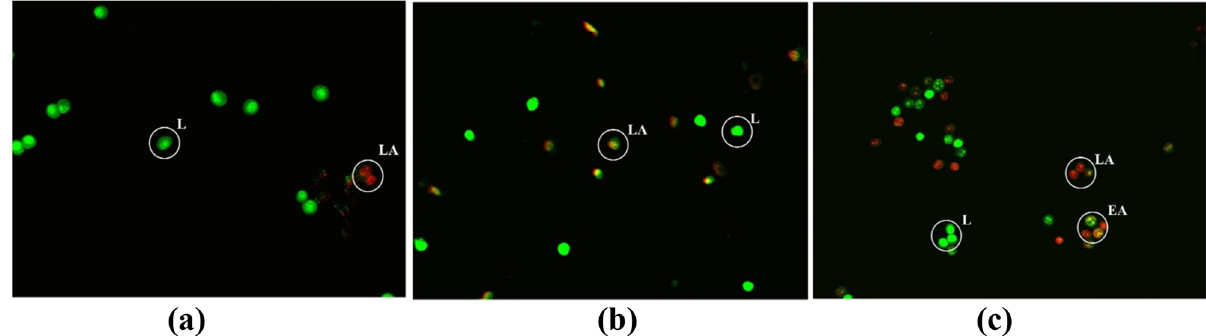
Figure 7: Fluorescence images of the untreated MCF - 7 cells ( a ) , treated with TecAn ( b ) , and PenAcAg ( c ) for 48 h at 37°C at IC 50 values and stained with AO/EB. “ L ” indicates live cells; “ EA ” indicates early apoptotic cells; “ LA ” indicates late apoptotic cells.